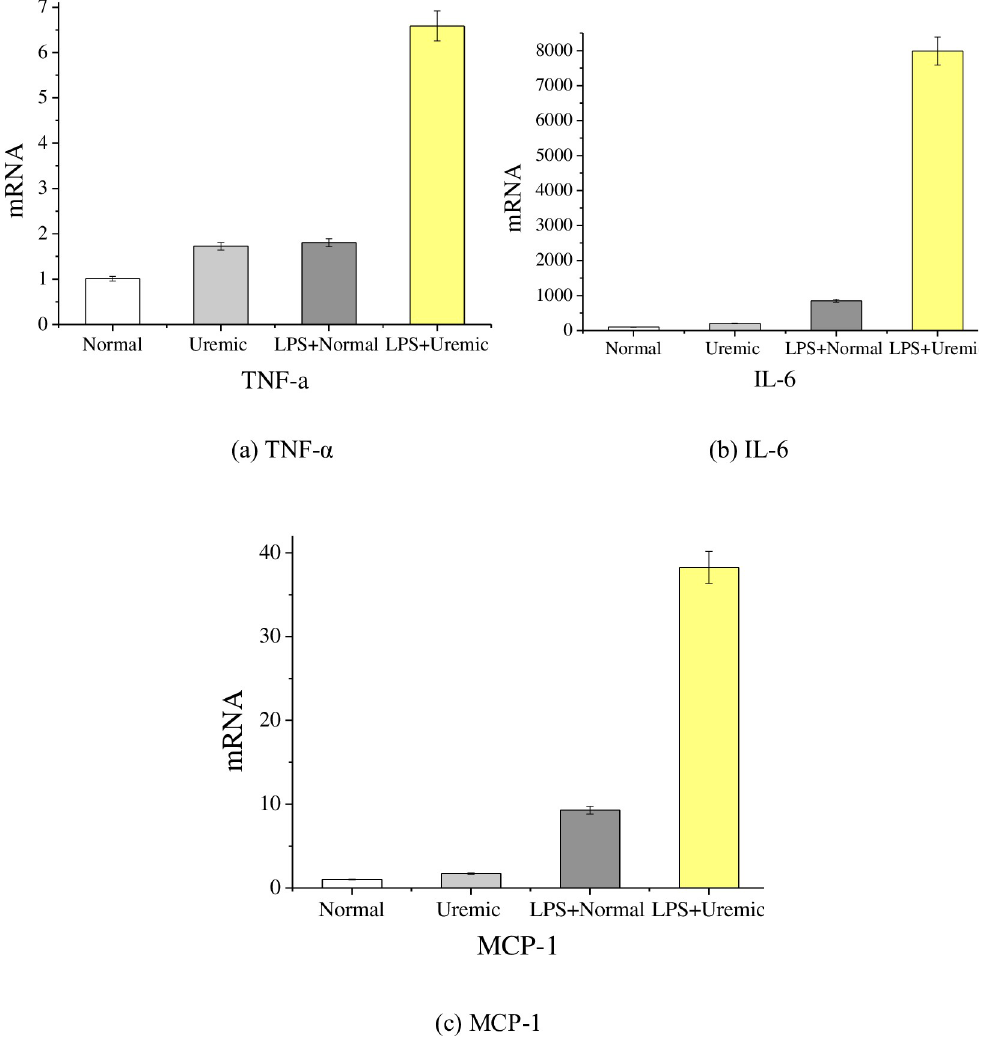
Fig 4. Effect of uremic serum on the expression of M1 marker in normal rats.